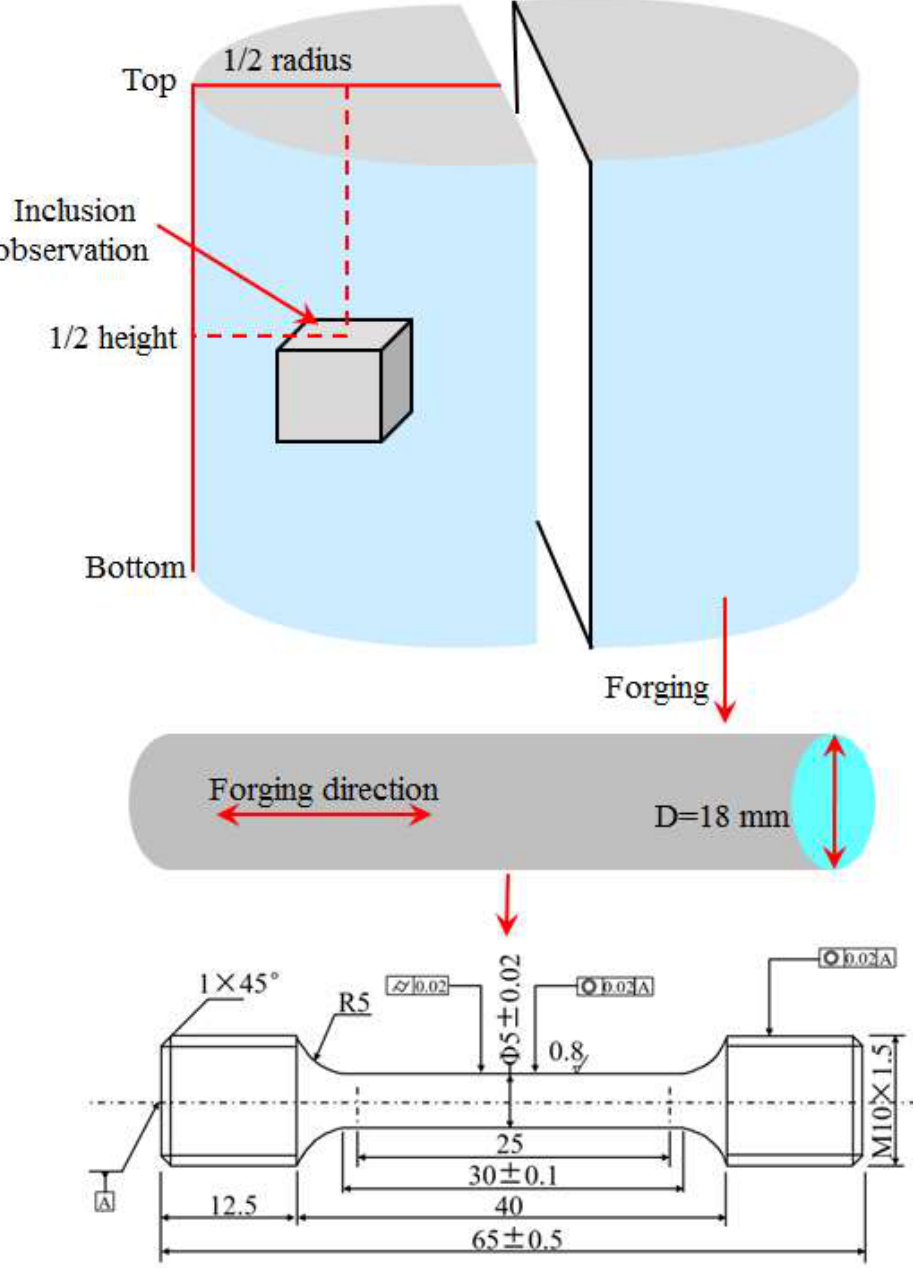
Figure 1. Sample treatment method for the inclusion observation and mechanical properties testing.